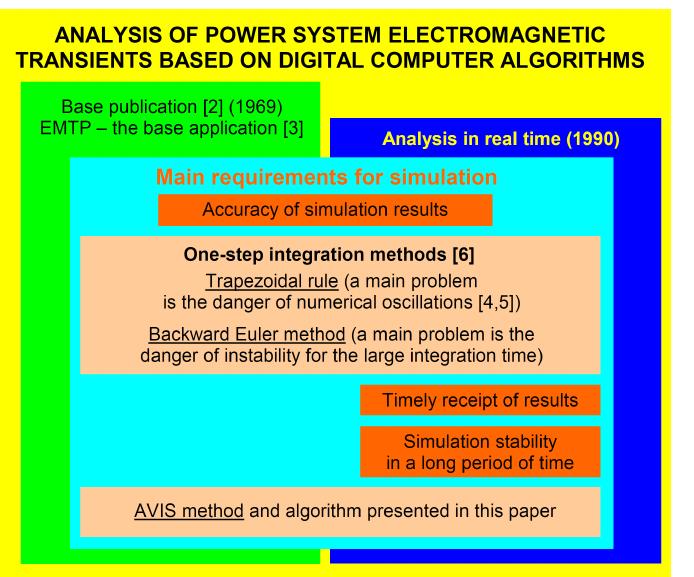
Figure 1. The place of one-step integration methods in the analysis of the dynamics of electrical